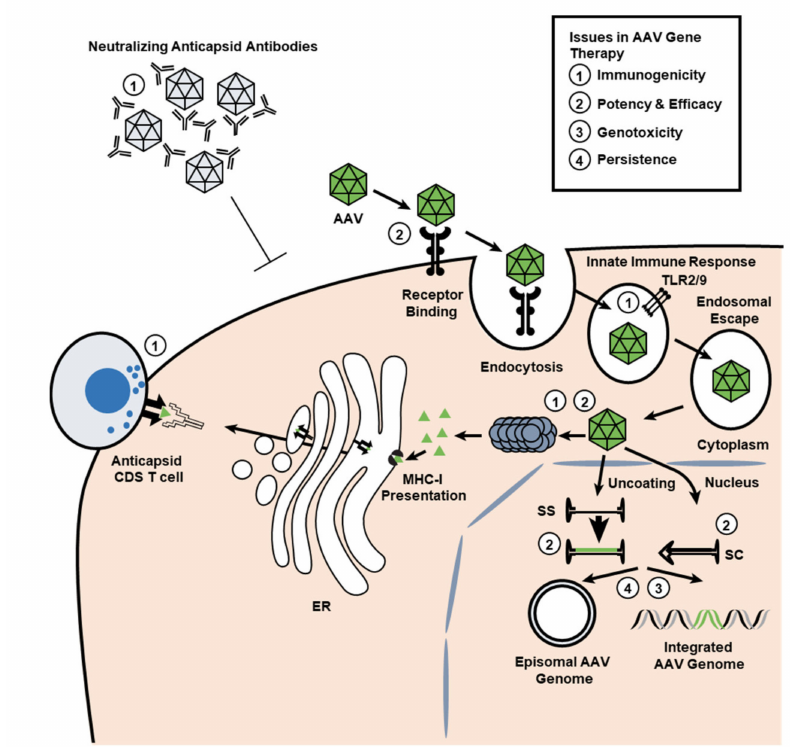
Figure 3. Potential limitations of gene transfer with AAV vectors [47]. Several potential immunologic- related issues to the AAV vector platform are emerging (white box): (1) Vector immunogenicity: the presence of neutralizing antibodies (NAbs) against the AAV capsid can prevent or limit cell transduction, whereas cytotoxic CD8+ T-cell responses can eliminate AAV-transduced cells that present AAV capsid antigens loaded on MHC-I complexes. (2) Potency and efficacy: the efficiency with which AAV vectors infect and transduce into the desired target cells can impact therapeutic doses and efficacy. (3) Genotoxicity: although rare, the integration of the AAV vector DNA into the genome of the infected cell may have genotoxic effects. (4) Persistence: the episomal AAV genome in the nucleus of the infected cells can be lost in conditions of cell proliferation (such as liver growth), which may impact therapeutic efficacy. AAV, adeno-associated virus; ER, endoplasmic reticulum; MHC-I, major histocompatibility complex class I molecule; sc, self-complementary; ss, single strand; TLR, Toll-like